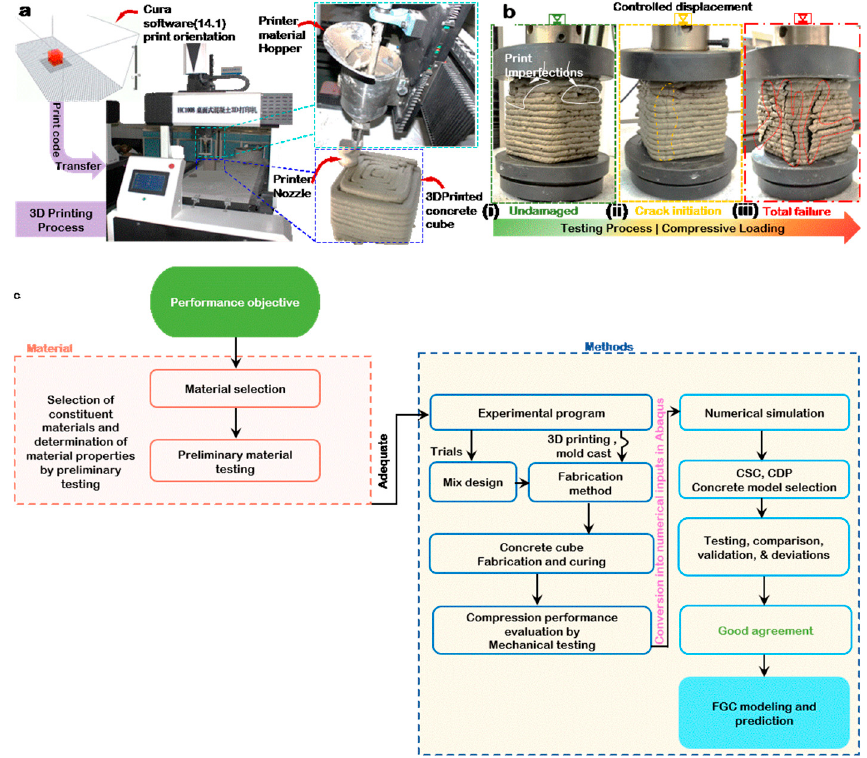
Figure 1. ( a ) 3D concrete model printing process. ( b ) Compressive strength test showing loading and failure. ( c ) Workflow of the